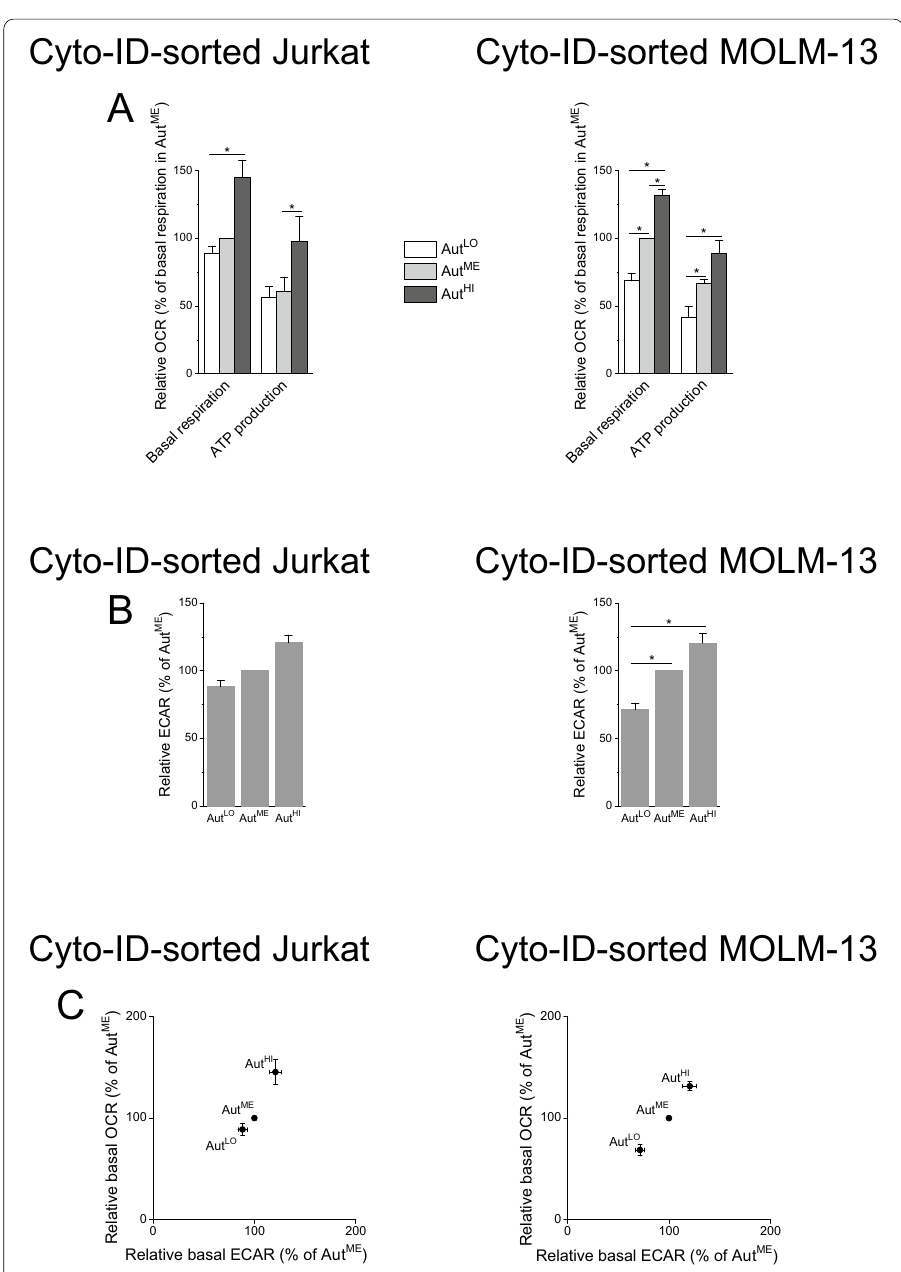
Fig. 6 Autophagic and metabolic activities are associated. Cells were flow‑cytometrically sorted on the basis of their Cyto‑ID fluorescence intensity into subpopulations with low, medium, and high Cyto‑ID fluorescence (Aut LO , Aut ME , and Aut HI , respectively). The subpopulations were subjected to metabolic analysis immediately after sorting. A OCR as a proxy for oxidative metabolism was measured with a Seahorse XFe96 Analyzer using a Cell Mito Stress Test. ATP production was calculated from OCR data (see Fig. S6 for details). B ECAR was measured as a proxy for glycolytic activity. OCR and ECAR of the three fractions were normalized to OCR and ECAR of Aut ME . C Energetic maps of sorted cells generated from OCR and ECAR data presented in A and B, respectively. Means SEM of each three independent measurements are shown; each biological replicate ± consisted of six readings (* P <